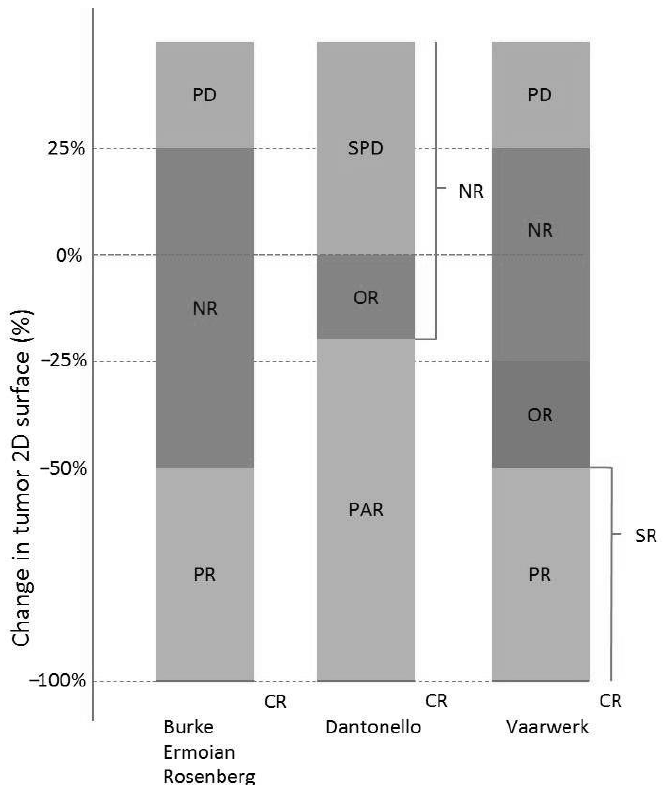
Figure 2. Grouping of response categories for the different studies. Categories expressed as change in tumor size, as measured in two-dimensional measurements %. Studies describing a different response measurement (i.e., one-dimensional or three-dimensional measurement) were recalculated. Abbreviations: CR, complete response; NR, non-response; OR, objective response; PD, progressive disease; PR/PAR, partial response; SPD, stable/progressive disease; SR, sufficient response. In three studies (Dantonello et al. [10], Ferrari et al. [12], and Vaarwerk et al. [14]) treatment after response assessment was adjusted in case of insufficient response based on the tumor size response.